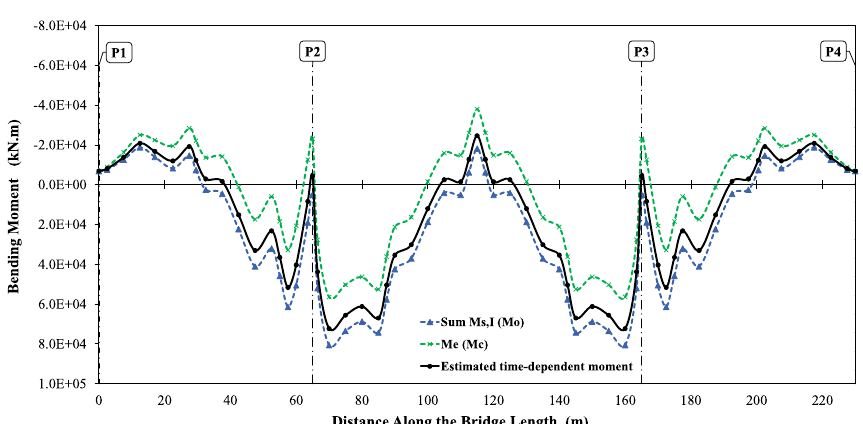
Fig. 21 Estimated time-dependent moments using the simplified approach per Kwak and Son (2002)–Talkha